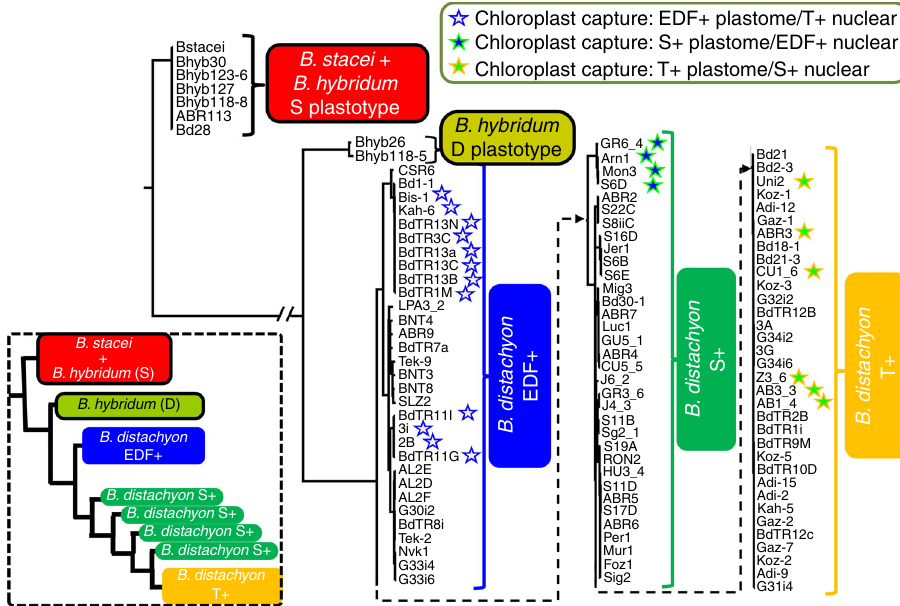
Fig. 5 Phylogenomic analysis of plastid genomes. Best maximum-likelihood Brachypodium phylogenomic tree based on plastomes. Most branches of main clades show strong support (see Supplementary Fig. 2a). B. stacei and B. hybridum- S plastotypes (red); B. hybridum D plastotypes (olive); B. distachyon EDF + clade (blue); B. distachyon S + group (green); B. distachyon T + clade (yellow). Stars highlight plastid capture events between the B. distachyon groups (see also Supplementary Fig.